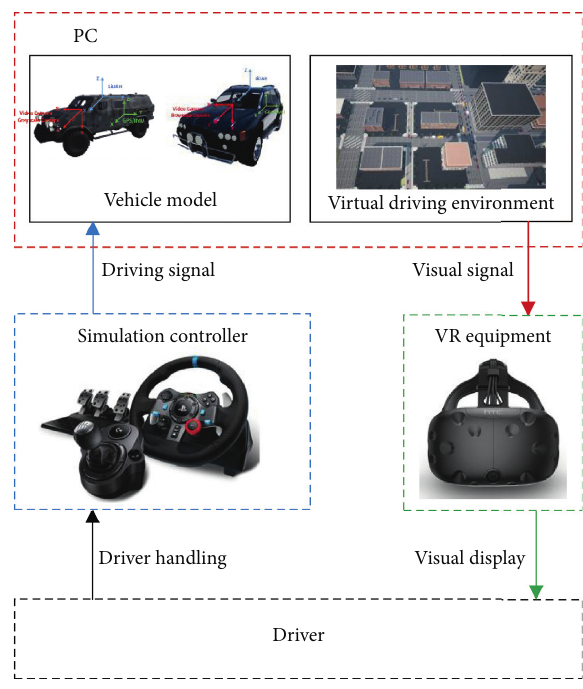
Figure 4: System architecture of the simulator.